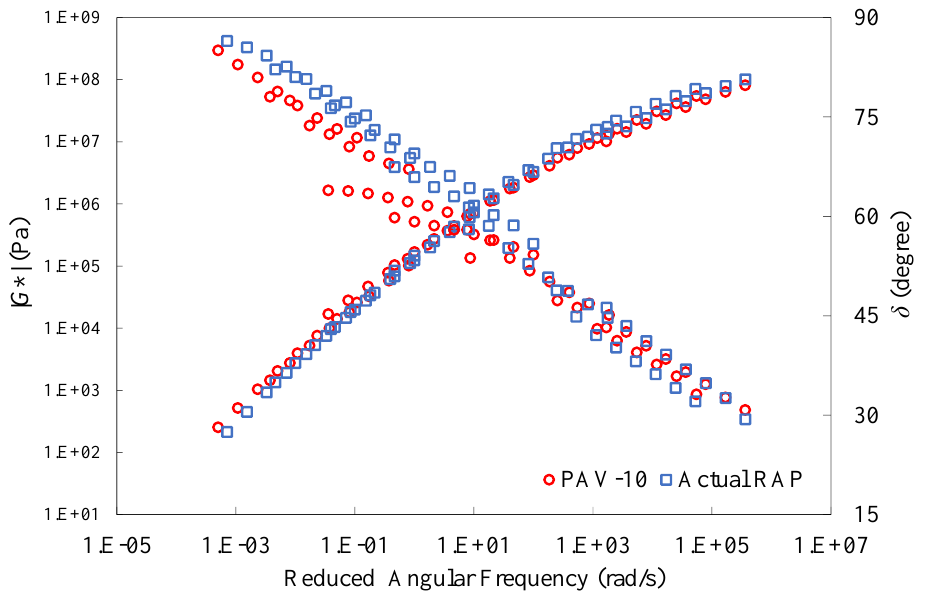
Figure 17. Master curves of dynamic modulus and phase angle for the actual RAP binder and the PAV-10 binder.